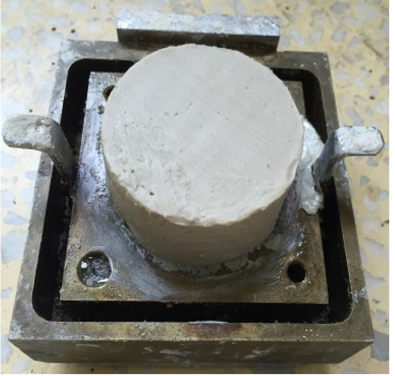
Figure 1. Standard cylinder sample of deep-sea simulant